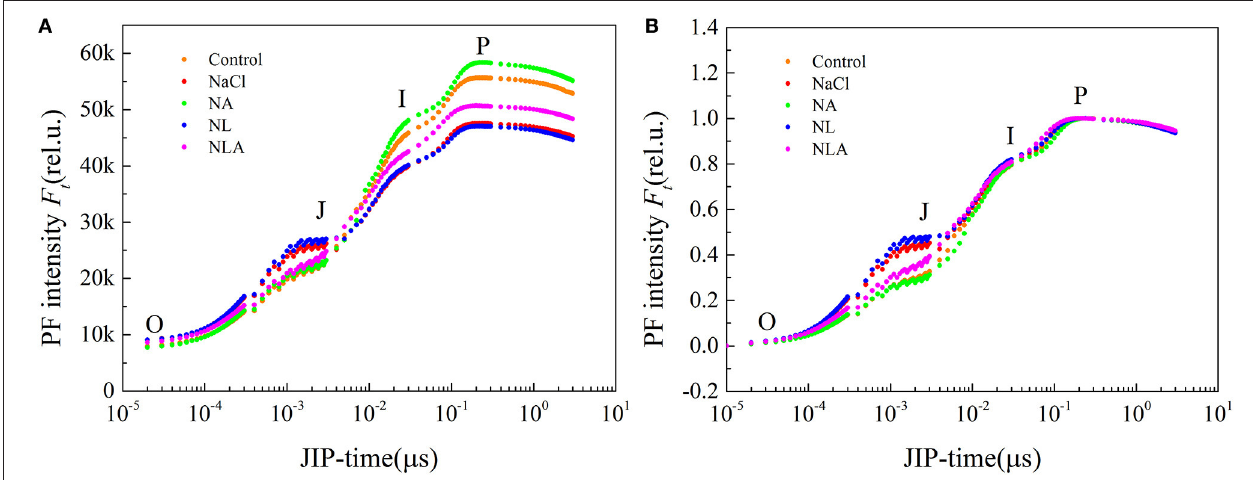
FIGURE 4 | Prompt fluorescence (PF) curves (A) and its normalized curves between O and P steps expressed as W O − P = [( F t − F o )/( F m − F o )] (B) in the leaves of salt-stressed tomato seedlings with or without exogenous ascorbic acid (AsA) and lycorine (LYC) spraying. Values are means ± SD ( n = 3). Control, no added NaCl, no sprayed AsA and LYC; NaCl, added 100 mmol/L NaCl; NA, added 100 mmol/L NaCl and sprayed 0.5 mmol/L AsA; NL, added 100 mmol/L NaCl and sprayed 0.25 mmol/L LYC; NLA, added 100 mmol/L NaCl and sprayed 0.25 mmol/L LYC and 0.5 mmol/L AsA.